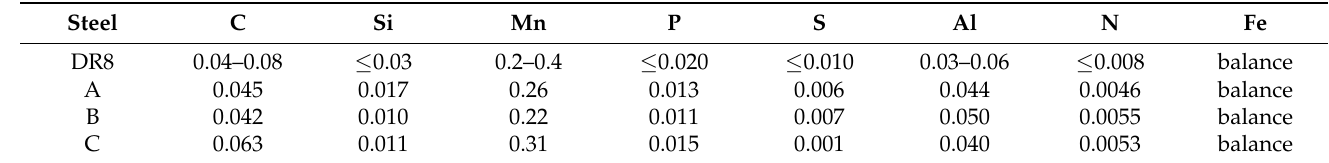
Table 1. Chemical composition of investigated materials (mass fraction, %).